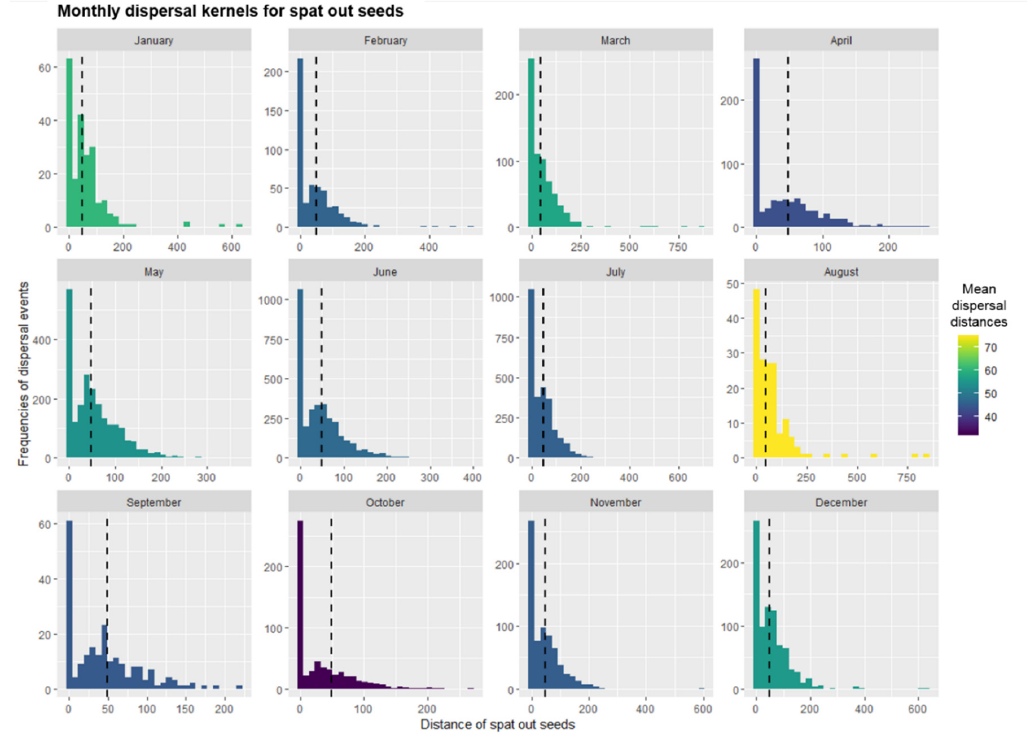
Figure 3. Simulated monthly total dispersal kernels for spat out seeds by the northern pigtailed macaques inhabiting the degraded forest fragment of Sakaerat. The dash line represents the total mean dispersal distance = 49 m.